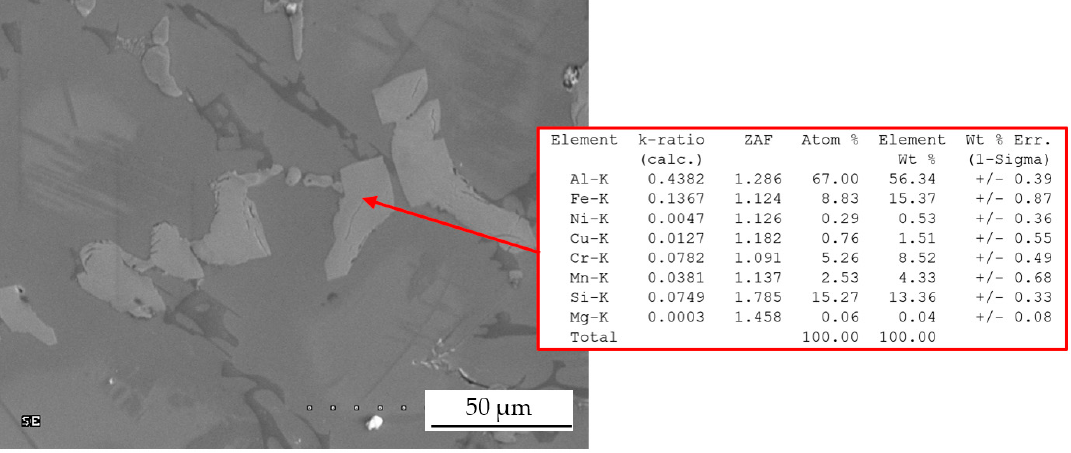
Figure 11. Point analysis of the chemical composition of the primary intermetallic phase in the microstructure of the tested alloy from the shell sand probe.